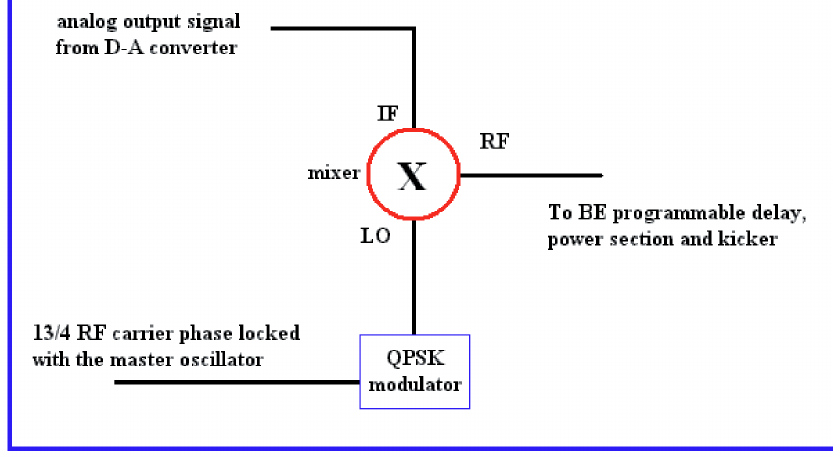
FIG. 5. (Color) LFB back-end block